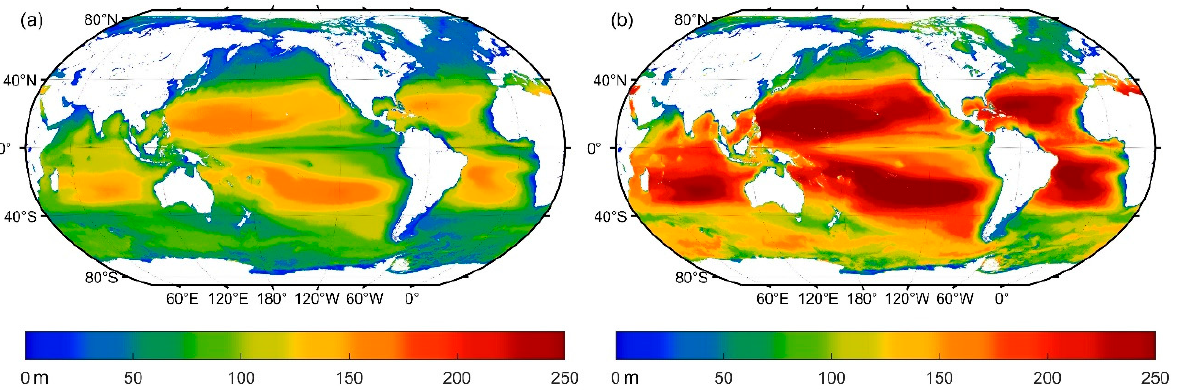
Figure 19. Depth penetration for the lidar could achieve with ( a ) a 10 5 dynamic range and ( b ) a 10 7 dynamic range with 490 nm, considering the strong backscattering of the sea